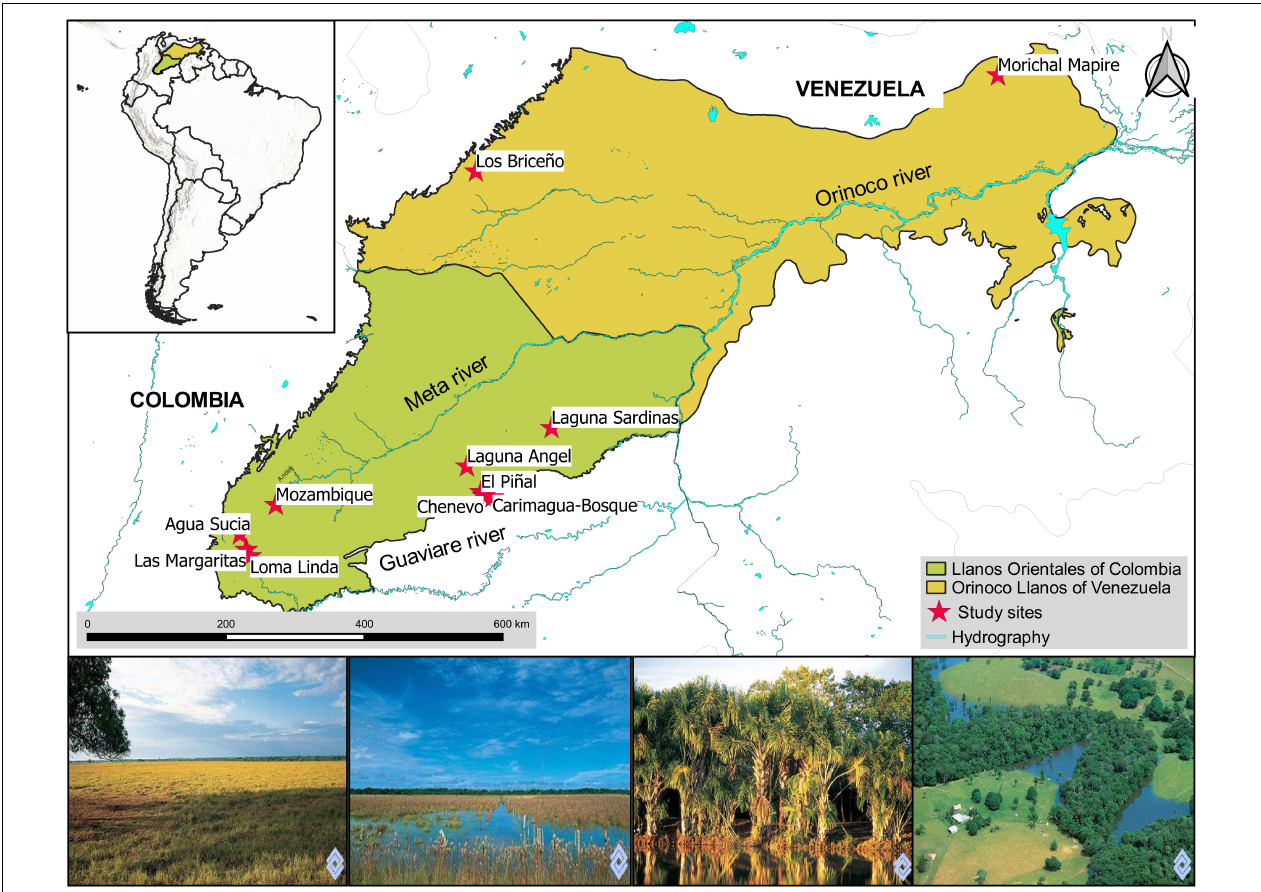
FIGURE 1 | Location of the Llanos of the Orinoco ecoregion in Northern South America together with the study sites reported in Colombia and Venezuela. At the bottom are photographs of the four vegetation types, from left to right: dry savannas, wet savannas, swamps (Morichal) and forests (photograph credits: Santiago Montes Veira and Francisco Forero